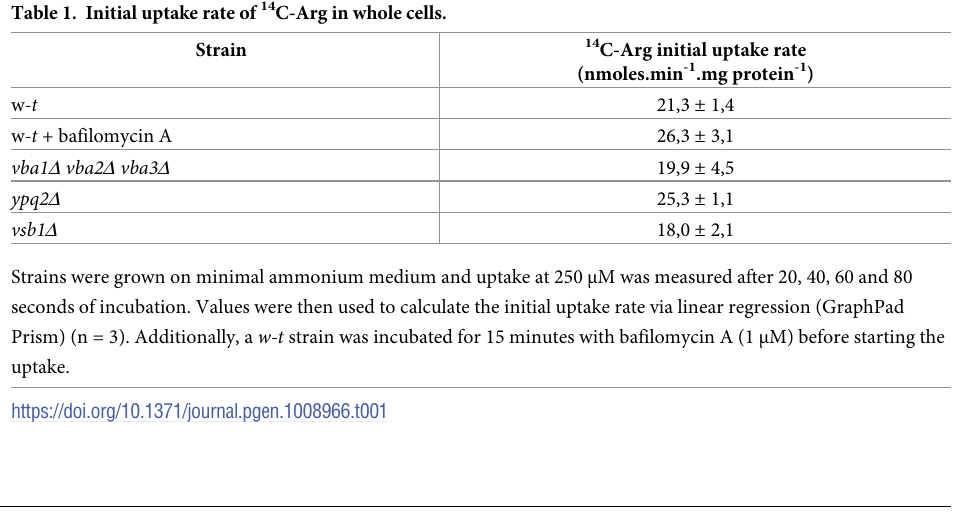
Table 1. Initial uptake rate of 14 C-Arg in whole cells.